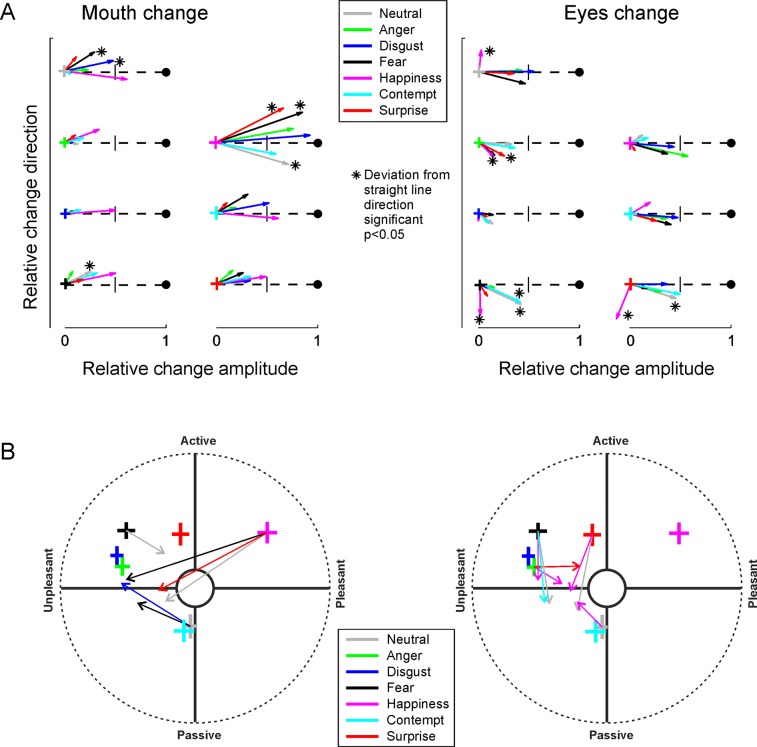
Shifts in perceived emotions due to incongruence.A) All shifts caused by changing the expression in the mouth region (left) or the eye region (right). The widths of the crosses indicate the 95% CIs (across participants) for the ratings of congruent expressions (see labels), the colours of the crosses indicate the congruent expression from which the mouth or eyes were changed. The arrows represent the perception shift caused by changing the eye region (left) or the mouth region (right) to that indicated by the arrow colour (see legend). The length of the arrows represents the relative magnitude of the change. An arrow that reaches the vicinity of the black circle at the end of the dashed line indicates that the percept completely followed the changed feature, an arrow that reaches the line perpendicular to the direct (dashed) path towards the centre indicates a percept based equally on both regions. Asterisks indicate shifts to directions which were of considerable magnitude but towards a direction that differs statistically significantly (t(31)>2.9, p<0.05 with Bonferroni correction in all tests, see Tables 1 and 2) from the direction expected based on the two emotions present in the composite faces (the dashed line). B) The unexpected shifts (indicated with asterisks in A), now presented in the V-A space.